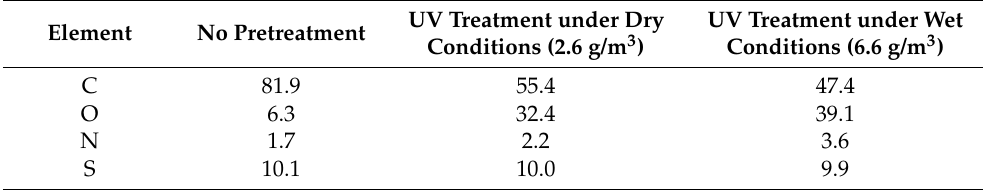
Table 5. Atomic ratio after each treatment (dry conditions: 7.8 g/m 3 and wet conditions: 16.0 g/m 3 ).